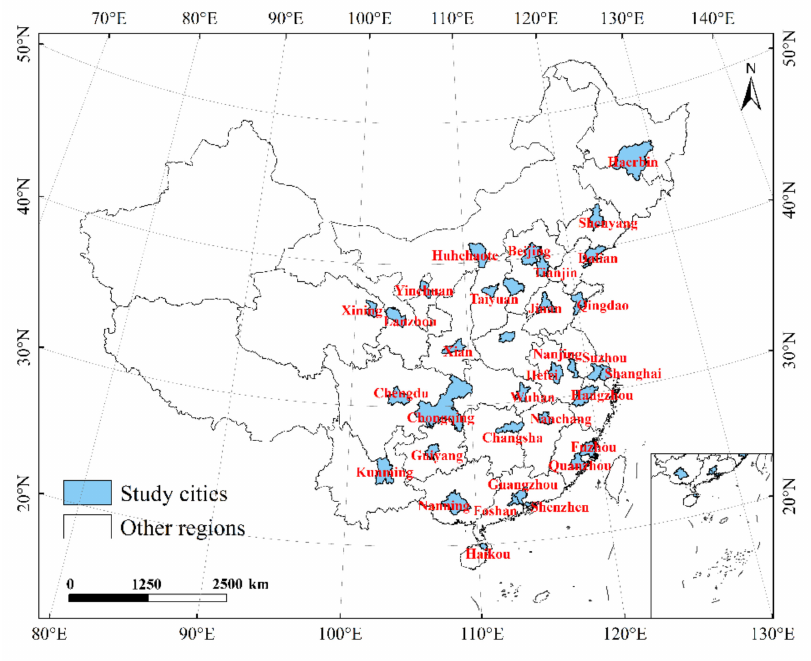
Figure 1. Study area in mainland China, including 34 cities.